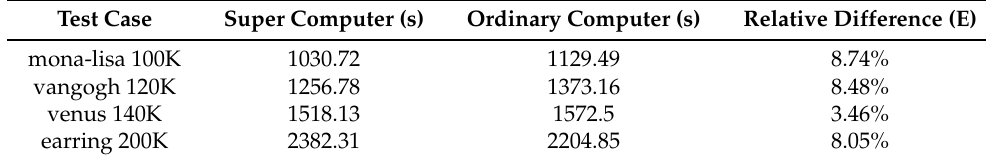
Table 5. Running time of the algorithm on two configurations of